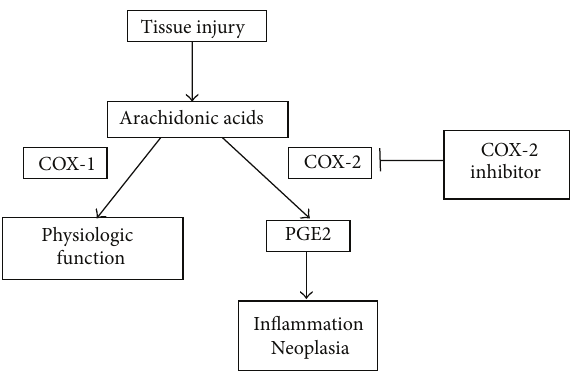
Figure 2: Cyclooxygenase